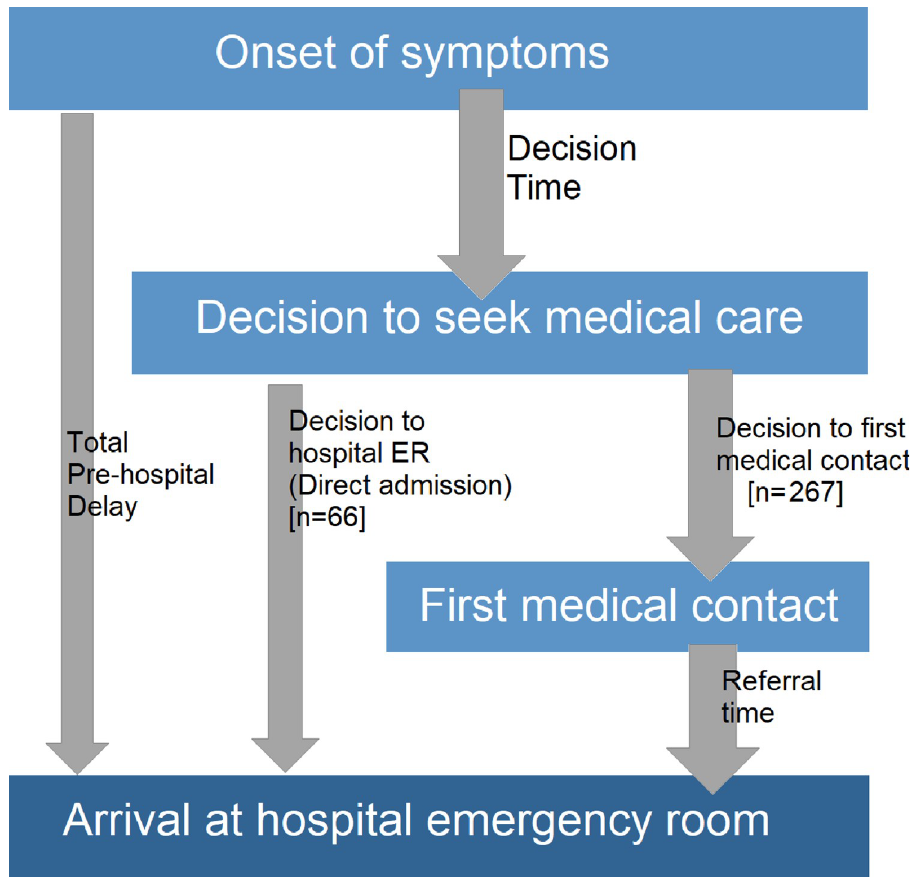
Fig 1. Working definitions for time intervals related to pre-hospital